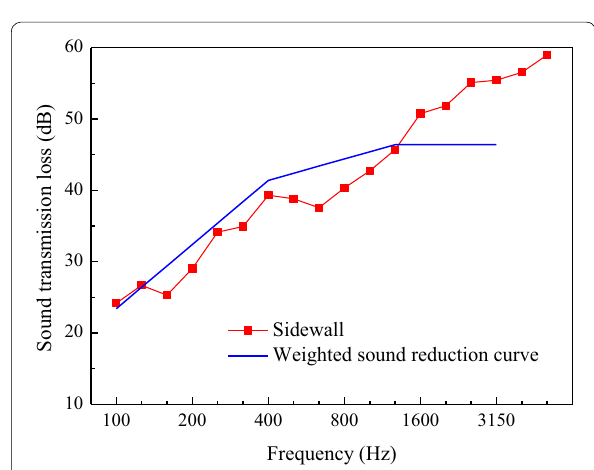
Figure 21 Average airborne sound transmission loss of the sidewall as a function of